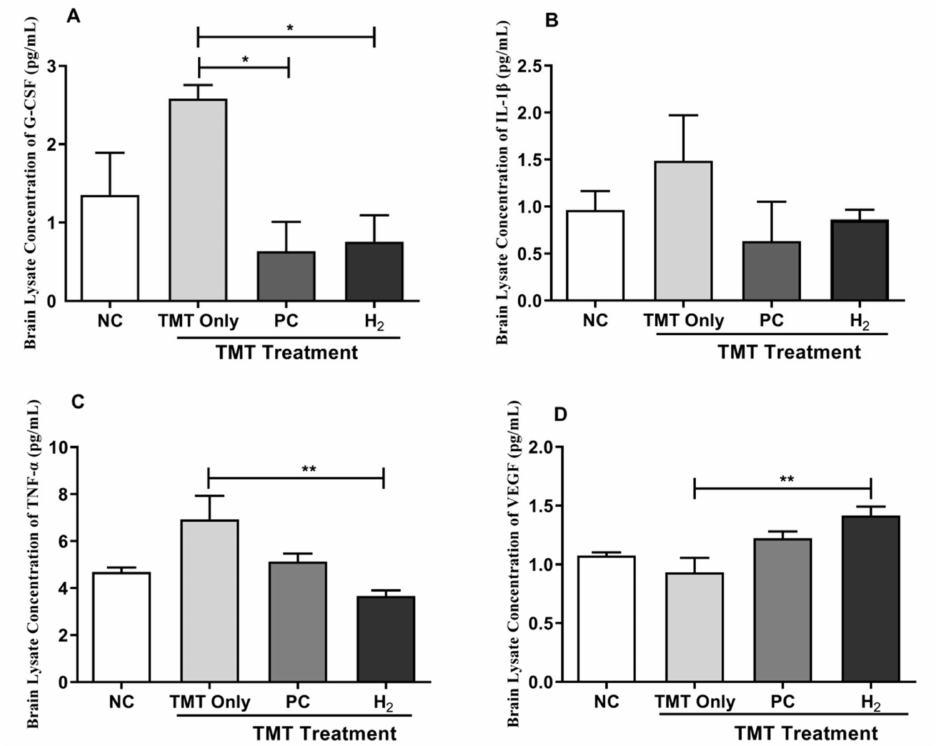
Figure 8. Effects of H 2 gas inhalation treatment on inflammatory cytokines and VEGF level in brain lysates in TMT-induced C57BL/6 mice after four weeks. ( A ) G-CSF, ( B ) IL-1 β , ( C ) TNF- α , ( D ) VEGF. Data are shown as the mean ± SEM for n = 4 mice. Significant differences were analyzed with ANOVA and Tukey’s test. * p < 0.05, ** p <